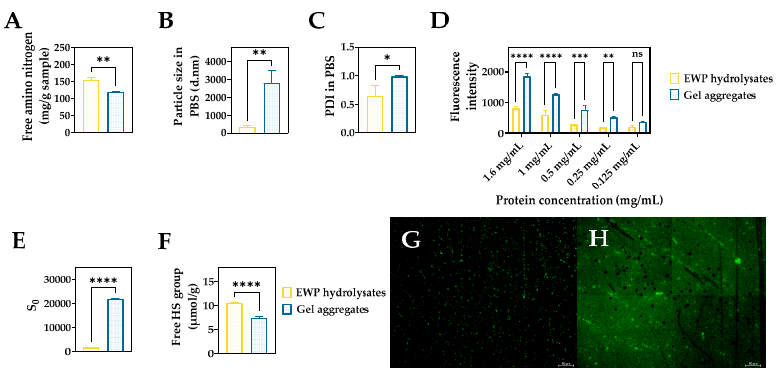
Figure 1. ( A ) Free amino nitrogen content, ( B ) particle diameter ( C ) polydispersity index (PDI), ( D ) ThT fluorescence intensity at different sample concentrations, ( E ) surface hydrophobicity (S0), and ( F ) free sulfhydryl group content of EWP hydrolysate and gel aggregate samples. ThT fluores- cence images of ( G ) EWP hydrolysates and ( H ) gel aggregates at 1.6 mg/mL. ns = not significant ( p ≥ 0.05), * = significant (0.01 < p < 0.05), ** = very significant (0.001 < p < 0.01), *** = extremely significant (0.0001 < p < 0.001), **** = extremely significant ( p < 0.0001). Scale bars represent 50 µ